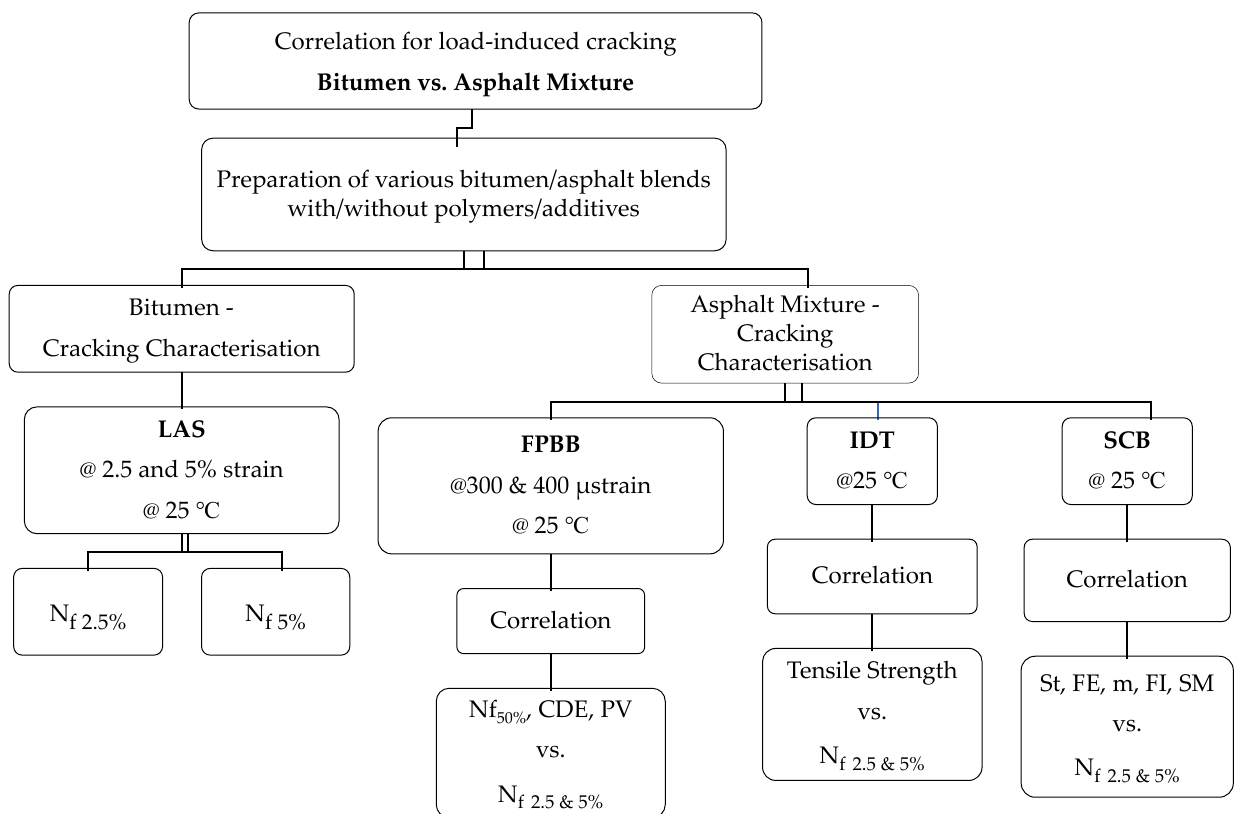
Figure 2. Experimental plan.